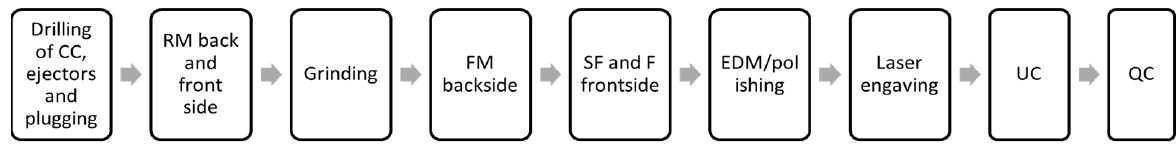
Figure 1. Mold insert for plastic injection molding (adapted with permission from from [26]).